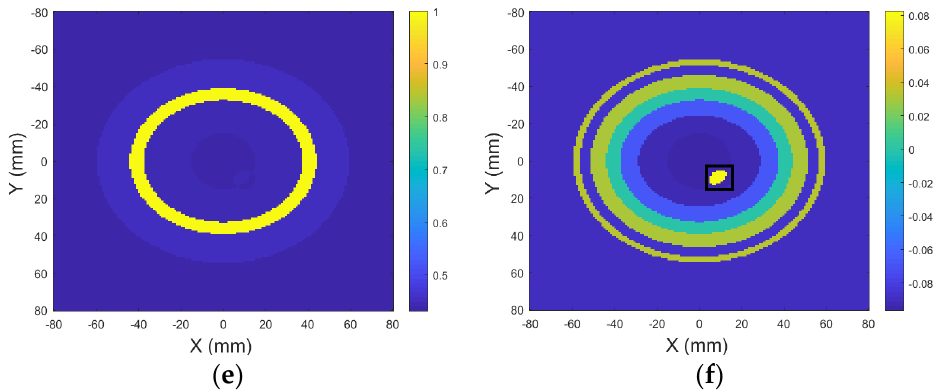
Figure 8. 3D view of the head mode: ( a ) Real part; ( b ) Imagery part; 3D reconstructed images: ( c ) Real part; ( d ) Imagery part; 2D reconstructed images: ( e ) Real part; ( f ) Imagery part.